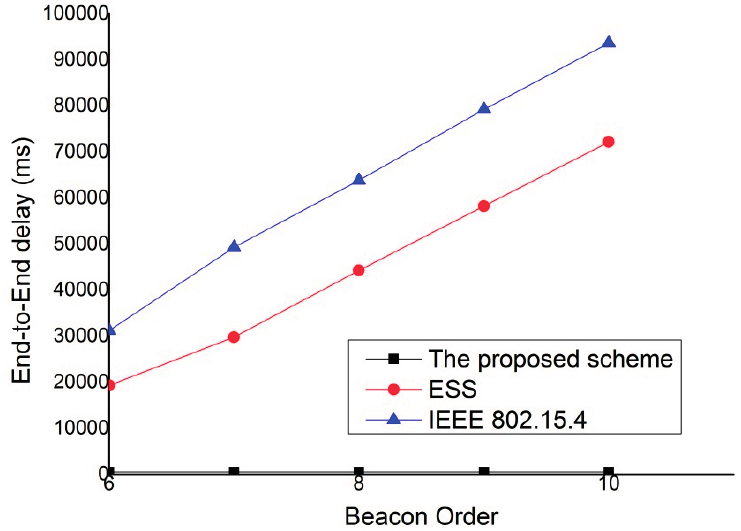
Figure 15. The throughput as a function of the average SNR.